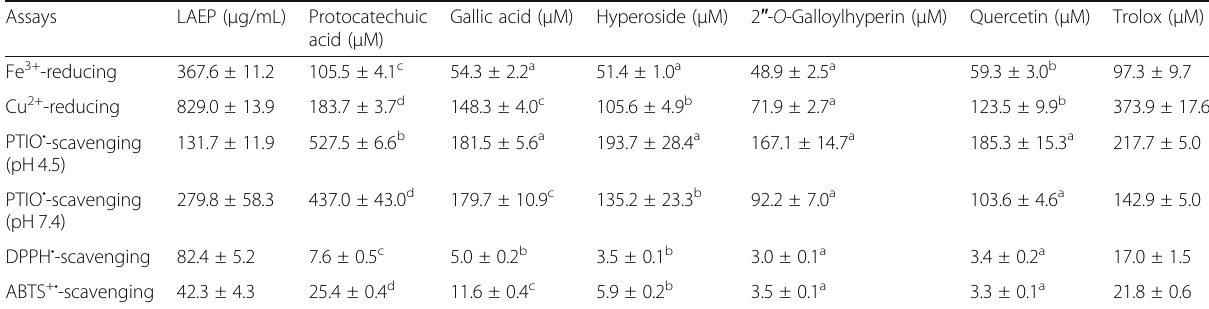
Table 1 The IC 50 values of LAEP and its five phenolic components in various antioxidant assays